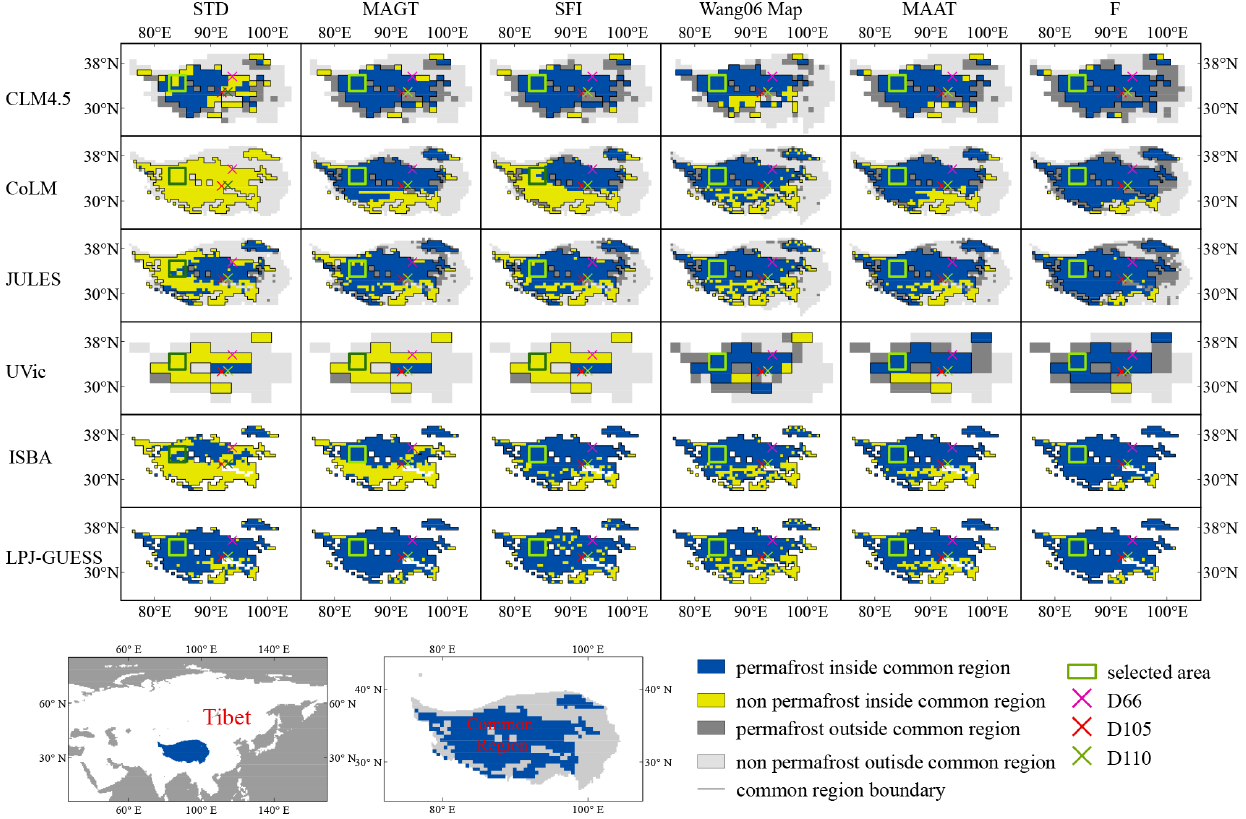
Figure 1. Permafrost maps derived from different diagnostic methods and models compared with the Wang06 map. Permafrost inside the common modeling region is used for all-models inter-comparison, while permafrost outside allows further evaluation over the whole TP for CLM4.5, CoLM, JULES and UVic. The observation-based map of permafrost (Wang et al., 2006) is re-gridded to match model resolution. The selected area in the western TP (33–36 ◦ N, 82.5–85.5 ◦ E) is used to examine across-model differences in Fig. 5. Insets show location map of TP and how the common region is related to the